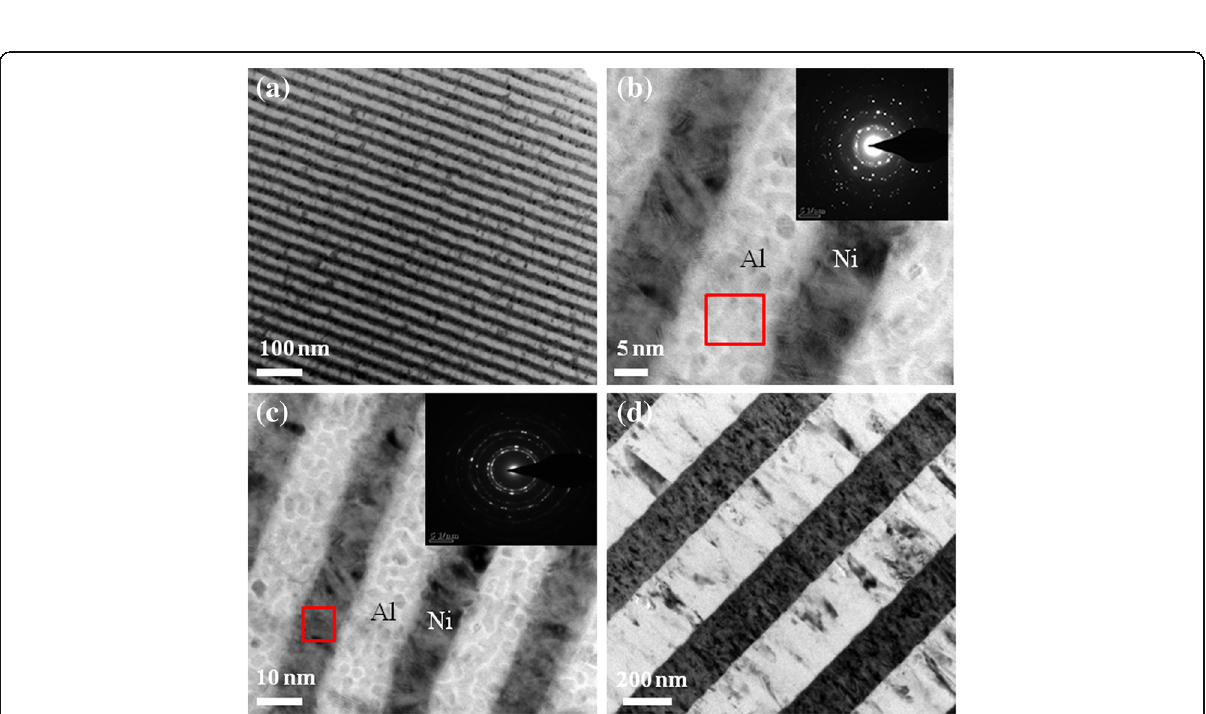
Fig. 3 a Cross-sectional bright-field TEM image of the energetic Al/Ni superlattice. b Electron diffraction pattern of the Ni layer. c Electron diffraction pattern of the Al layer. d Cross-sectional bright-field TEM image of the Al/Ni